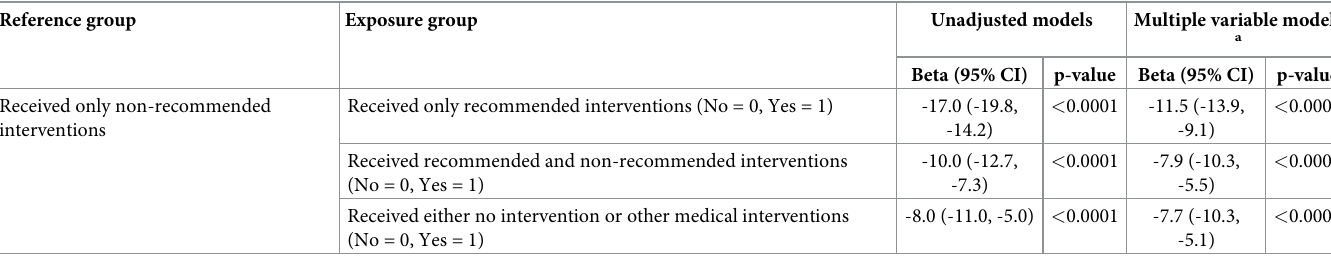
Table 3. Univariate and multiple variable quantile regression results testing the influence of guideline adherence on lost workdays. Reference